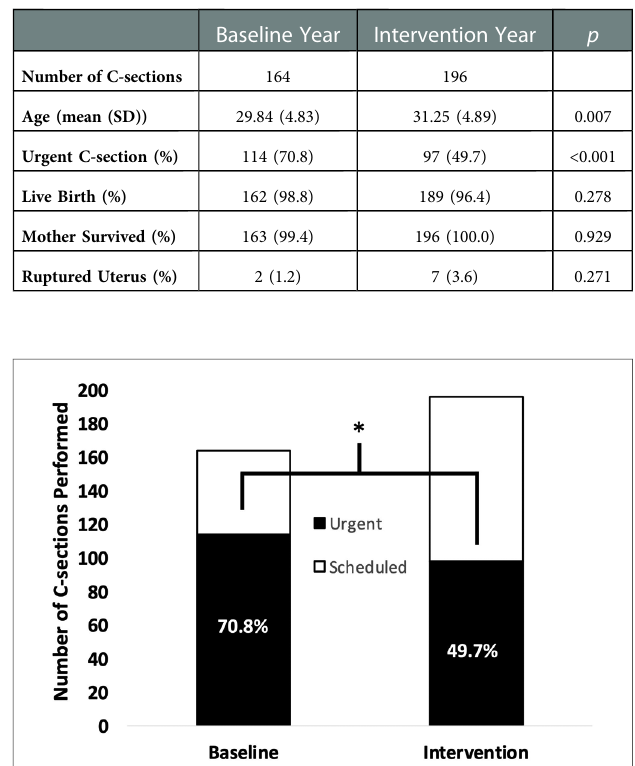
TABLE 1 Additional outcomes between the baseline and intervention periods.